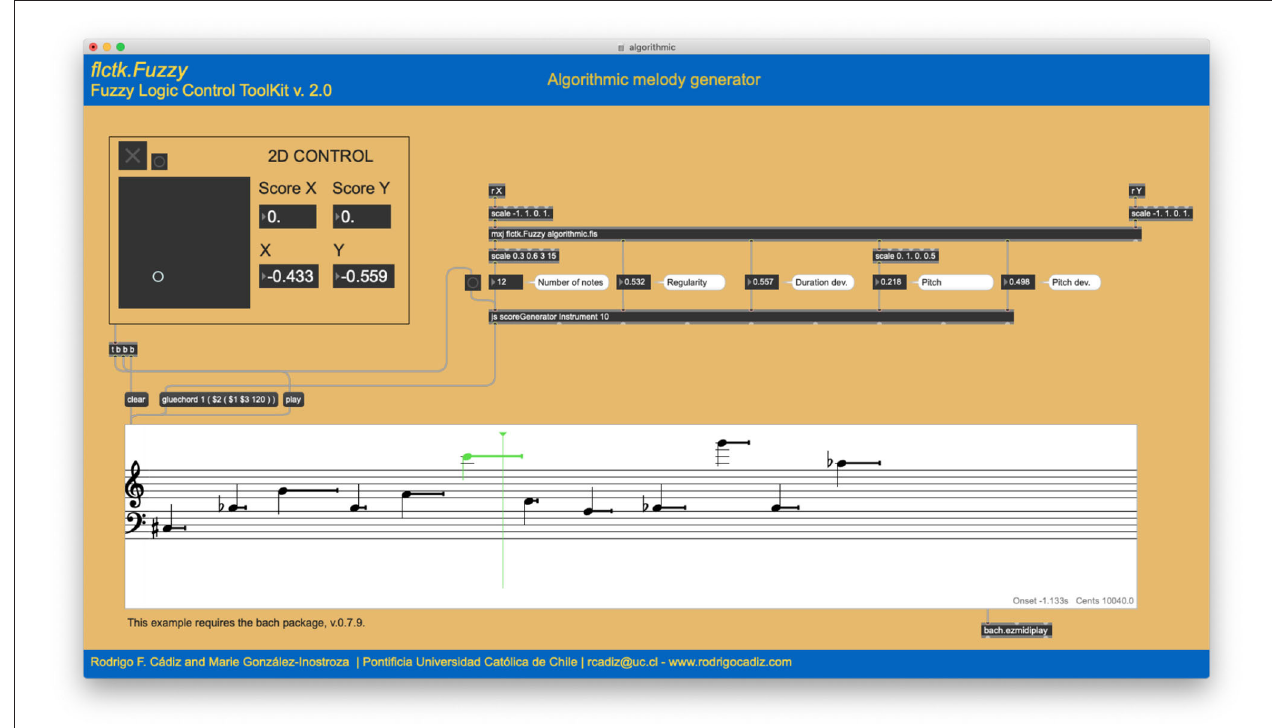
FIGURE 3 | Algorithmic melody generator example 1. The 2D coordinates [ − 0.433, − 0.559] of the latent space generate a 12-note melody with a large range of pitch